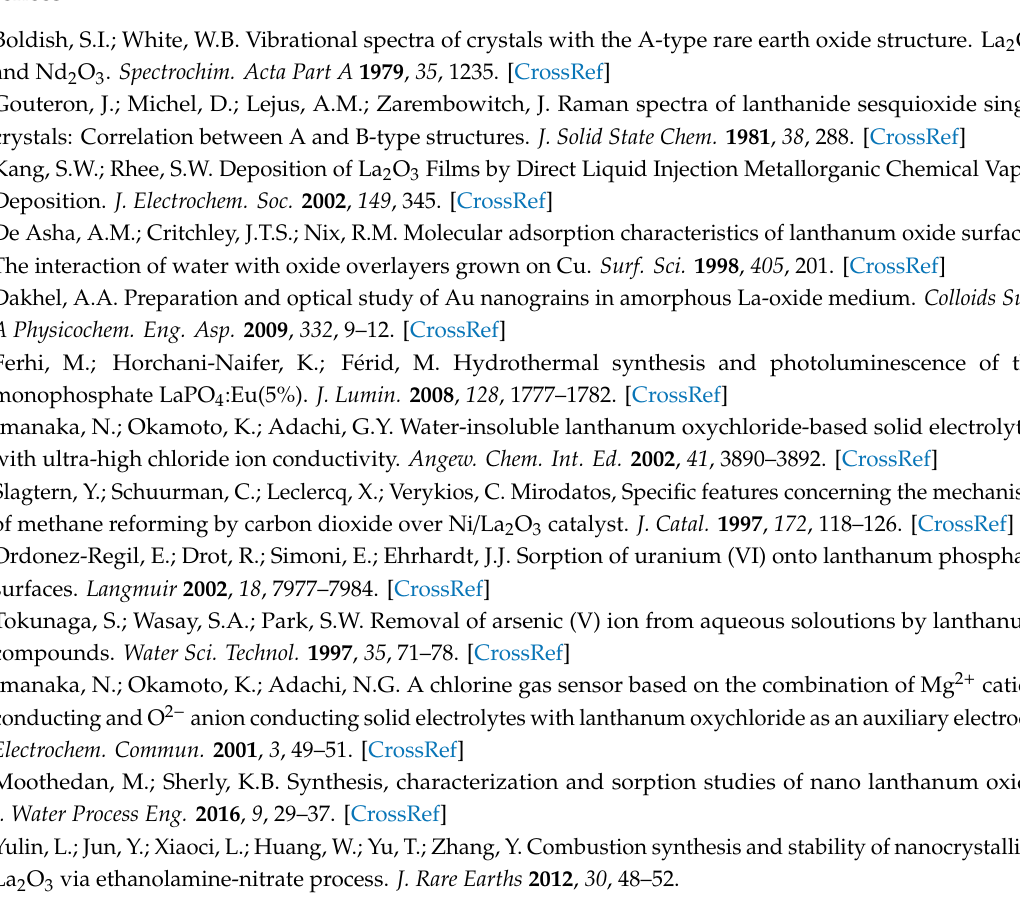
Figure S1. SEM-EDX spectrum of La 2 O 3 nanorods without N 2 atmosphere (a) and of La 2 O 3 nanorods with N 2 atmosphere (b). Figure S2.pH initial versus pH final graph and initial di ff erence for pH pzc calculation for La 2 O 3 . Figure S3. PFO (a) and PSO (b) kinetcis model linear fitting plots for As(V) adsorption on to La 2 O 3 nanorods. Metal initial concentration: 10 mg / L, Adsorbent dosage: 0.1 g / L, at pH 6, and 25 ◦ C. Figure S4. Langmuir